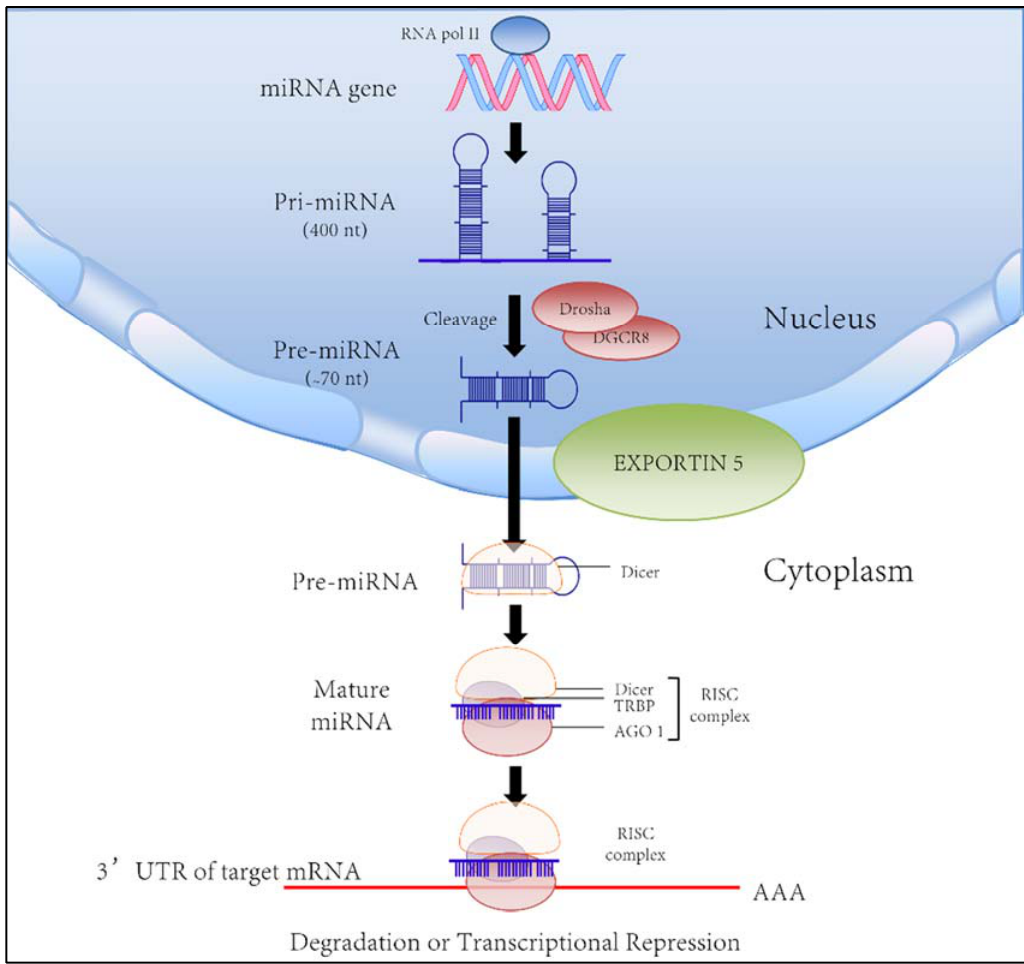
Figure 1. microRNA biogenesis . MicroRNA (miRNA) genes are transcribed by RNA polymerase II (Pol II) to generate the primary transcripts (pri-miRNAs). The initial processing of the primary transcript is mediated by the Drosha-DiGeorge syndrome critical region gene 8 (DGCR8; Pasha in Drosophila melanogaster and Caenorhabditis elegans) complex (also known as the Microprocessor complex) that generates ~70 nucleotide (nt) pre-miRNAs. Pre-miRNA has a short stem plus a ~2-nt 3 ′ overhang, which is recognized by the nuclear export factor exportin 5. Once exported from the nucleus, the cytoplasmic RNase III Dicer catalyses the production of miRNA duplexes. Dicer, TRBP (TAR RNA-binding protein; also known as TARBP2), and Argonaute (AGO) 1–4 mediate the processing of pre-miRNA and the assembly of the RISC (RNA-induced silencing complex). Within this complex, one strand of the miRNA duplex is removed resulting in a single stranded miRNA, partially complementary to target mRNA, which remains in the complex. .The “seed” sequence (positions 2 – 7 from the 5 ′ end of miRNAs) is complementary to the 3 ′ UTR of mRNA targets. microRNA complex interaction with mRNA induces posttranscriptional silencing through as both mRNA destabilization and translational repression (author’s figure)